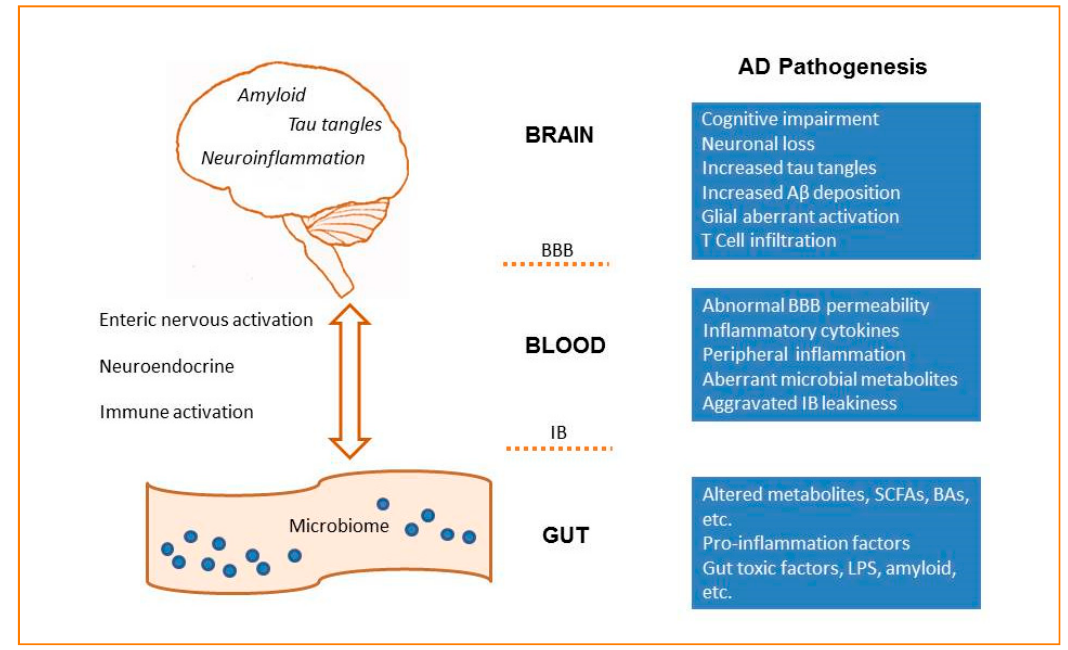
Figure 1. The microbiota–gut–brain axis in AD. The microbiota–gut–brain axis is a bidirectional communication system that includes neural, immune, endocrine and metabolic pathways. Dysbiosis of gut microbiota would affect the permeability of the intestinal barrier (IB), induce the leak of the brain–blood–barrier (BBB), and aggravate neuroinflammation and AD pathologies.